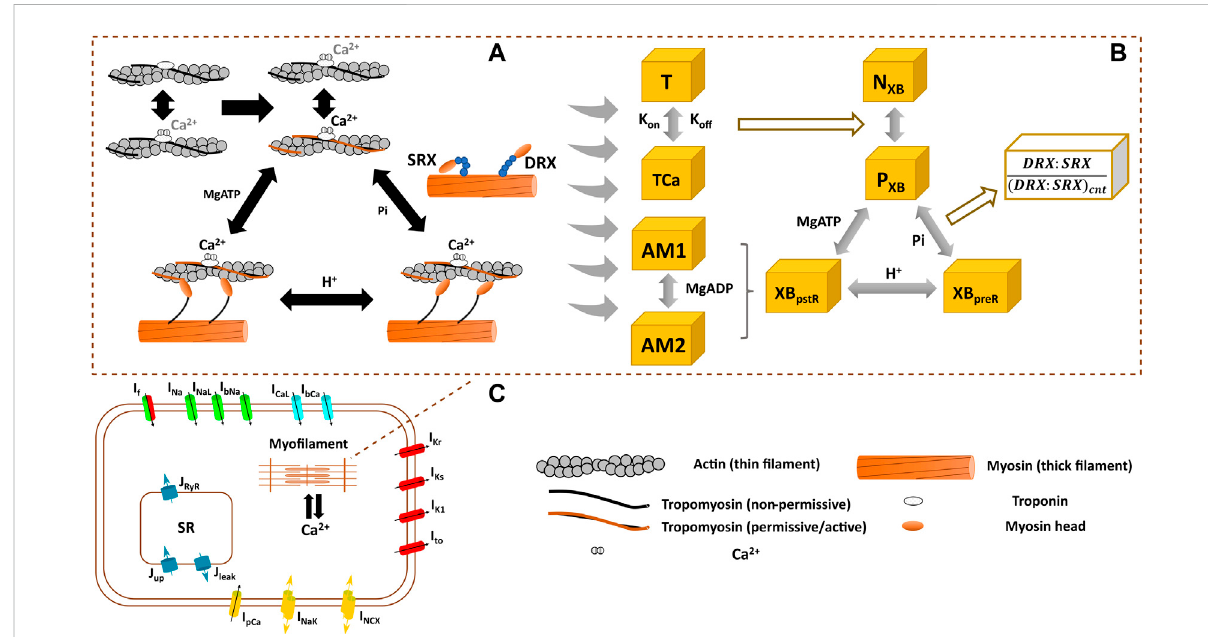
FIGURE 1 Schematicsoftheinter fi lamentcouplingincardiacforcegeneration (A) themodelledcrossbridge(XB)cyclingusedinhiMCEmodel (B) ,andthe schematic of hiPSC-CM cell main functional components (C) . DRX: Disturbed relax state. SRX: Super relaxed state. T: troponin, TCa: Ca 2+ bound troponin, N XB : non-permissive state preventing XB formation, P XB : permissive state of XB formation, XB preR : strongly bound XB before isomerised rotation, XB pstR : XBin strongly bound post isomerised rotation state, AM1and AM2 are strongly-bound rapid equilibrium substatescontributing equally to the force generation and we assumed MgADP binds to AM1 (Tran et al.,